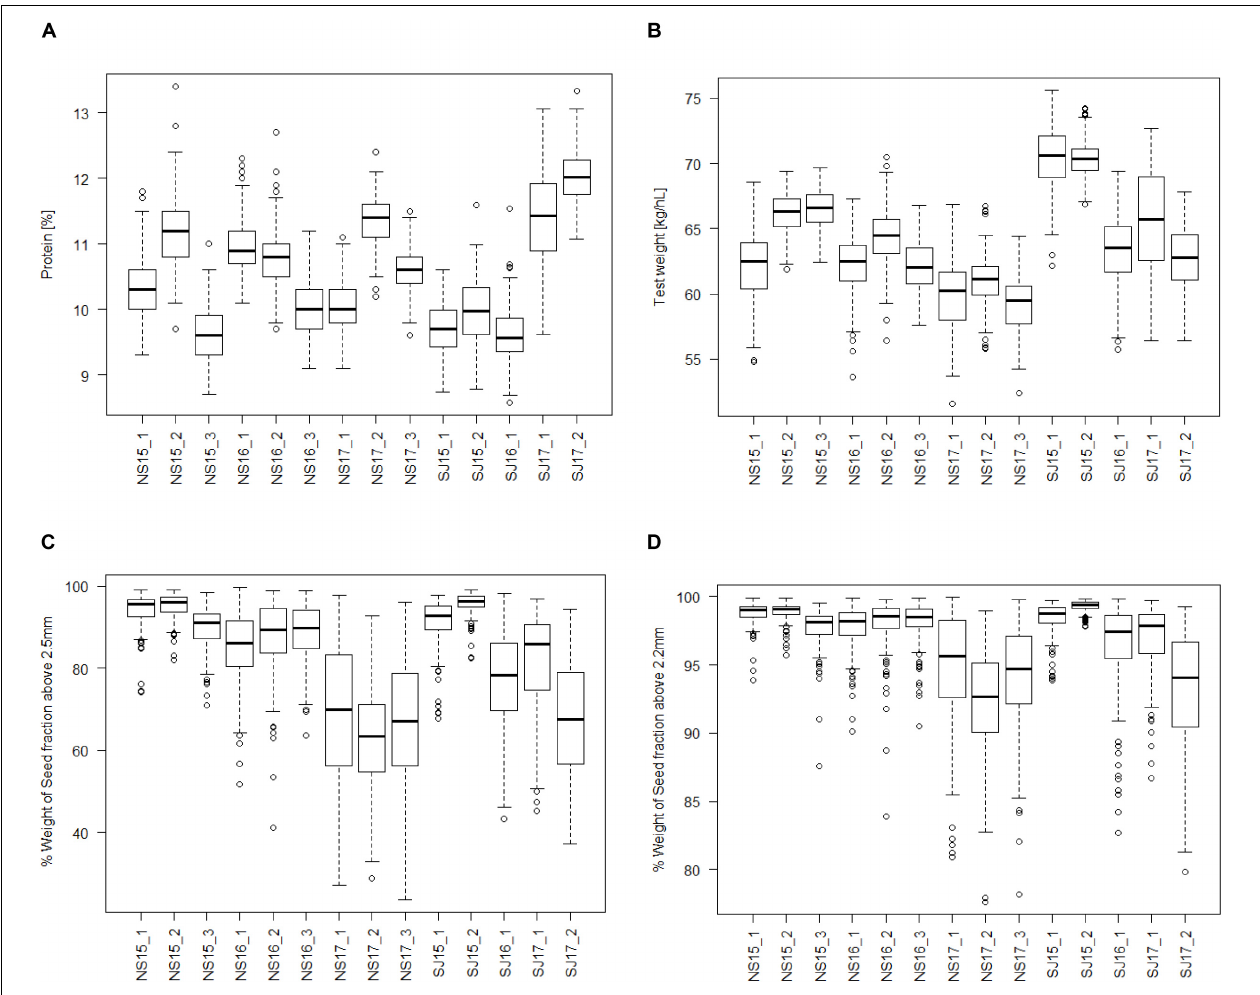
FIGURE 1 | Boxplot of seed quality trait distributions among the 14 environments (company-year-location). (A) Protein content, (B) test weight, (C) seed fraction SF_abv2.5; and (D) seed fraction